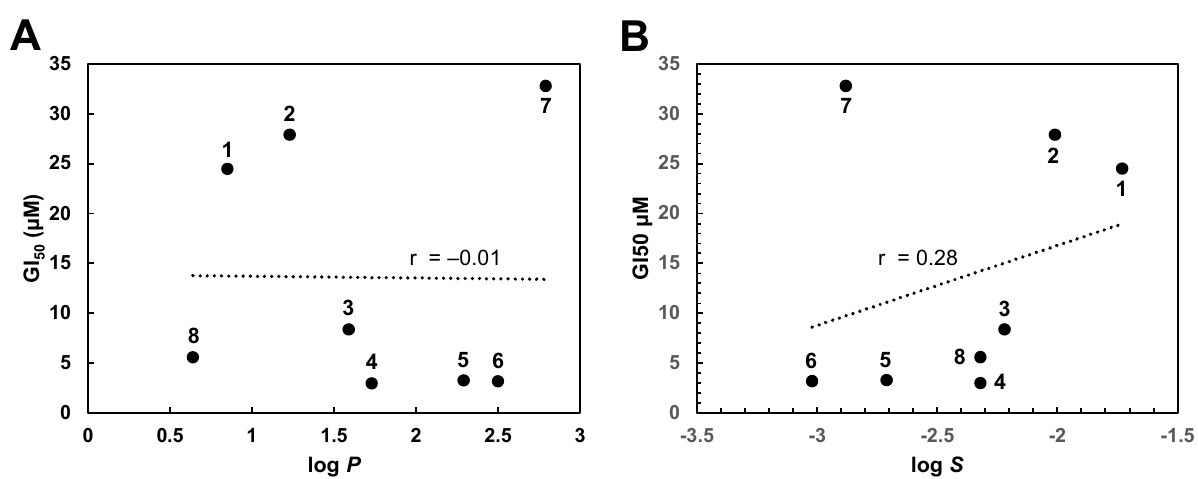
Figure 2. Correlation between predicted log P ( A ) and log S ( B ) values and GI 50 values of gallic acid alkyl esters. The numbers shown refer to the individual gallic acid alkyl esters. Predicted log P val- ues of gallic acid alkyl esters 1–8 were calculated using the Interactive logP Calculator from Molinspi- ration Cheminformatics [23]. As the correlation coefficient is −0.01 (−0.1–0.0), there is no association between the log P values and the GI 50 values. Predicted log S values of gallic acid alkyl esters 1–8 were determined with SwissADME [24]. With a correlation coefficient of 0.28 (0.1–0.39), there is a weak association between the log S values and the GI 50 values.